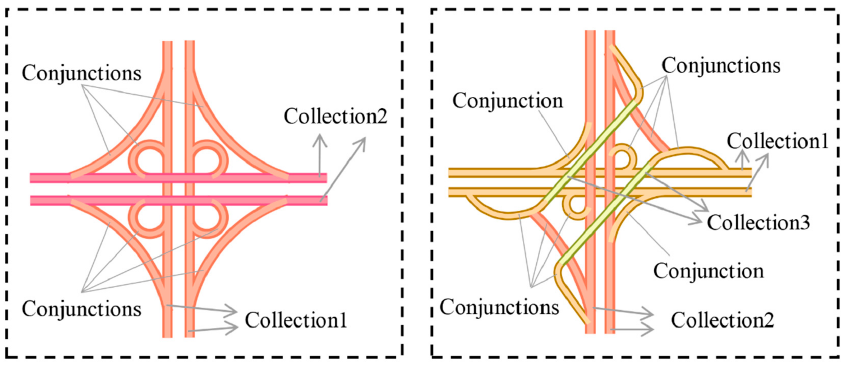
Figure 12. Two road networks with different elevations.